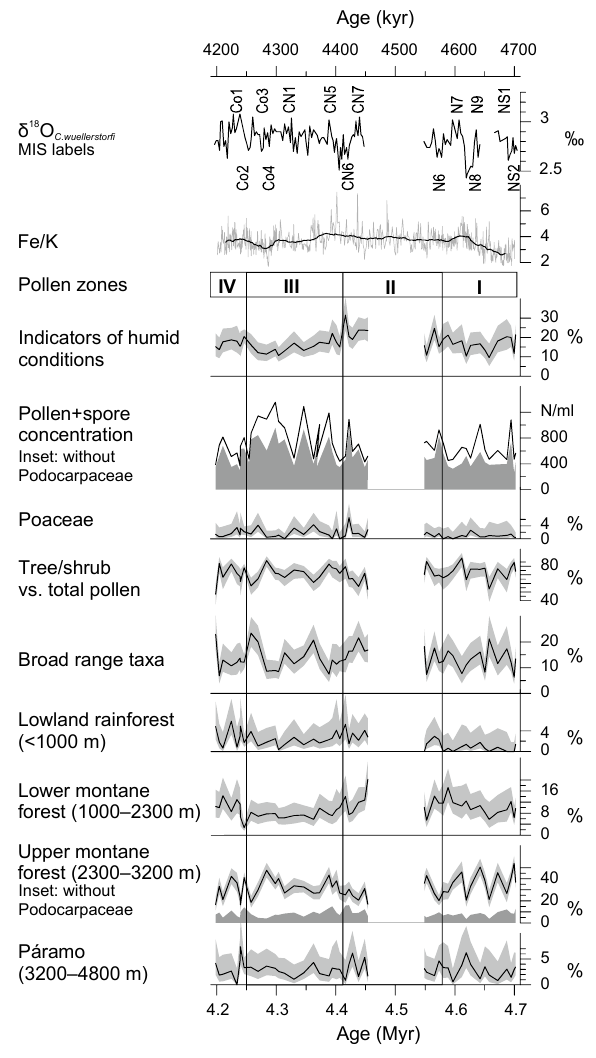
Figure 4. Palynomorph percentages of ODP Hole 1239A for the four vegetation belts and other groups from 4.7 to 4.2Ma. Grey shading represents the 95% confidence intervals (after Maher, 1972). Vertical black lines delimit the pollen zones. At the top stable oxygen isotopes of the benthic foraminifer C. wuellerstorfi (Tiedemann et al., 2007) of ODP Hole 1239A, marine isotope stages (MIS), and elemental ratios of Fe / K from holes 1239A and 1239B. Ages are from Tiedemann et al. (2007). A coring gap is present in Hole 1239A between 4.45 and 4.55Ma.